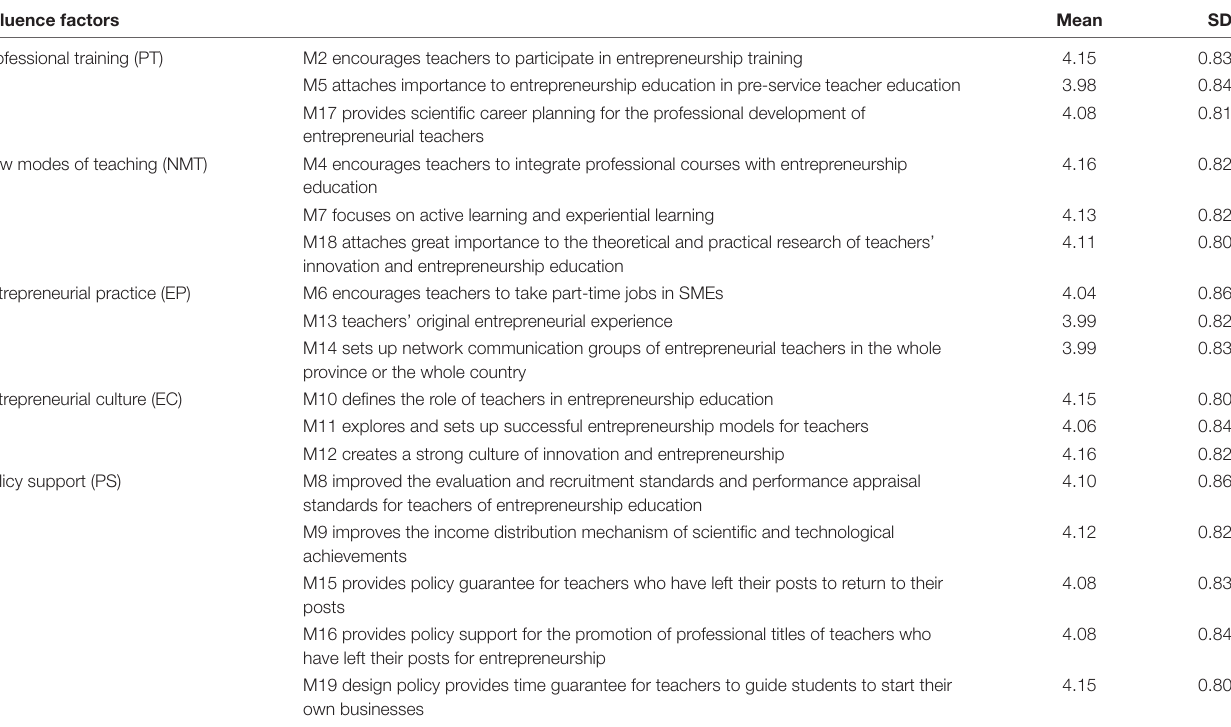
TABLE 3 | Factors link to teachers’ competencies of entrepreneurship